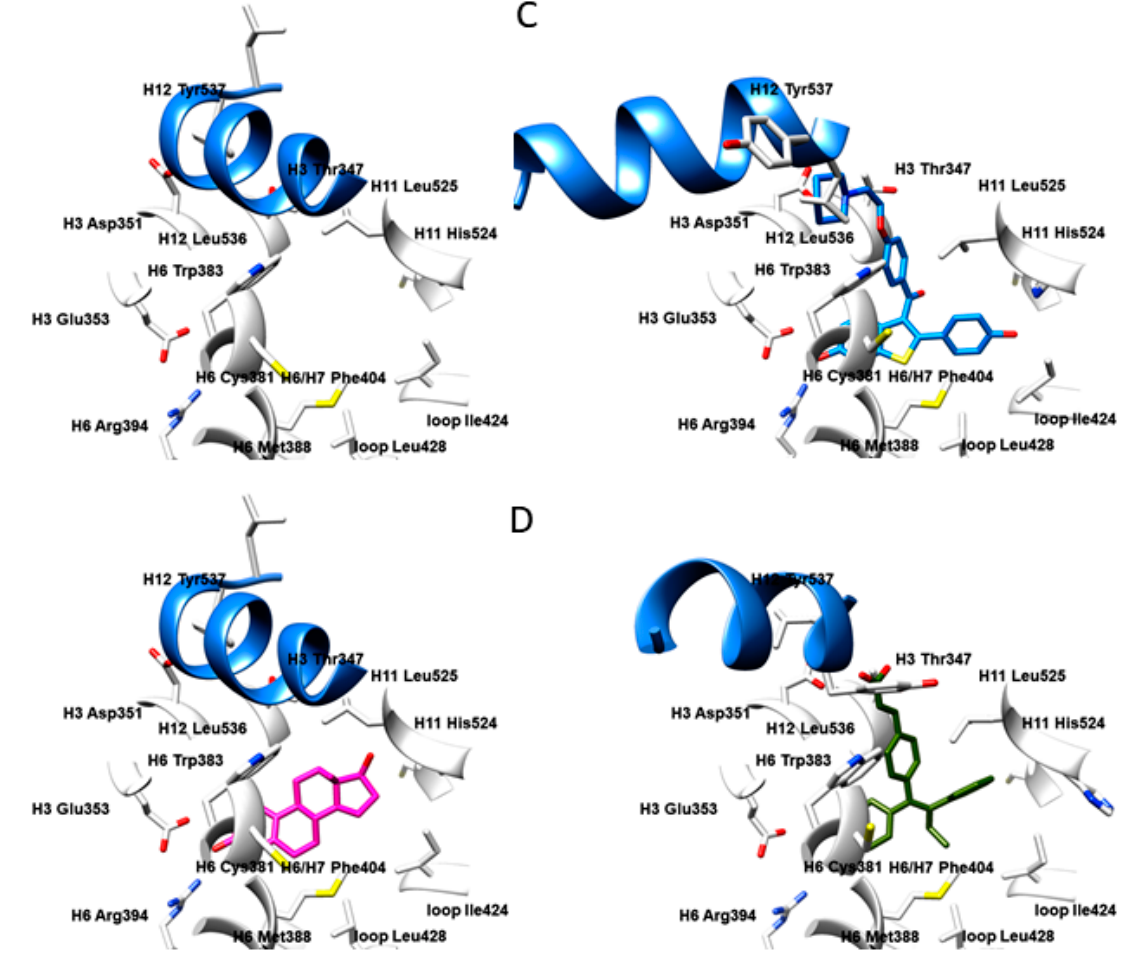
Figure 1. The active site of ER α in the apo form (PDB ID: 4Q13 [21]) ( A ); in complex with 17 β - estradiol (PDB ID: 1ERE [13], i.e., agonist/partial agonist) ( B ); in complex with Raloxifene (PDB ID: